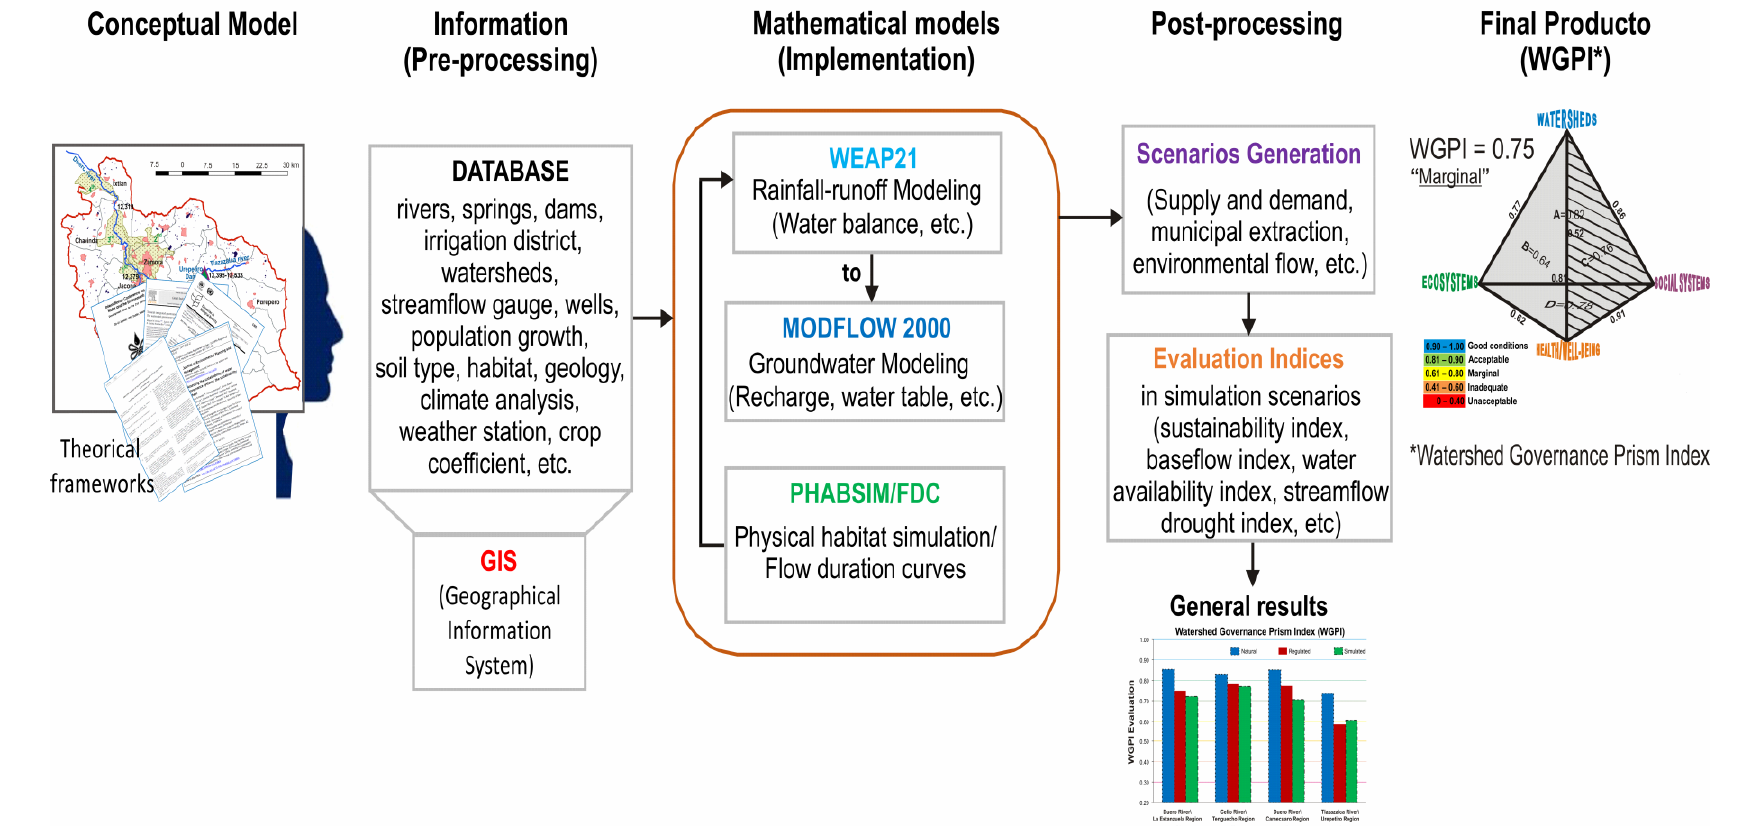
Figure 3. Conceptual model proposed to obtain the Watershed Governance Prism Index (WGPI).